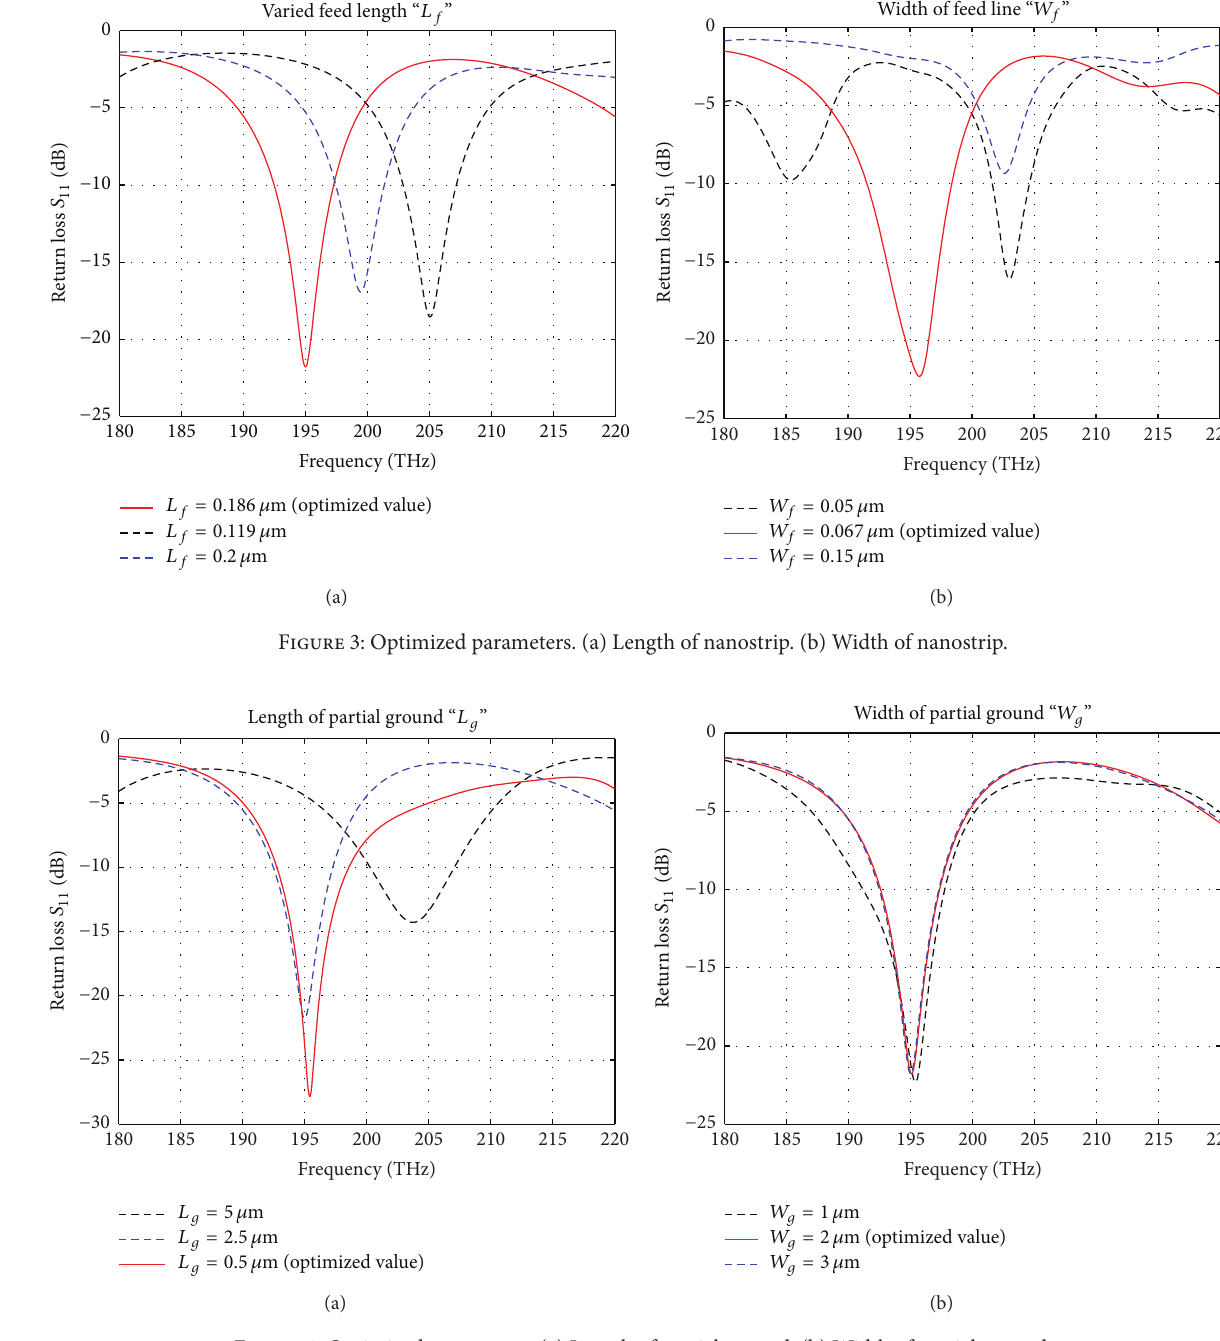
Figure 4: Optimized parameters. (a) Length of partial ground. (b) Width of partial